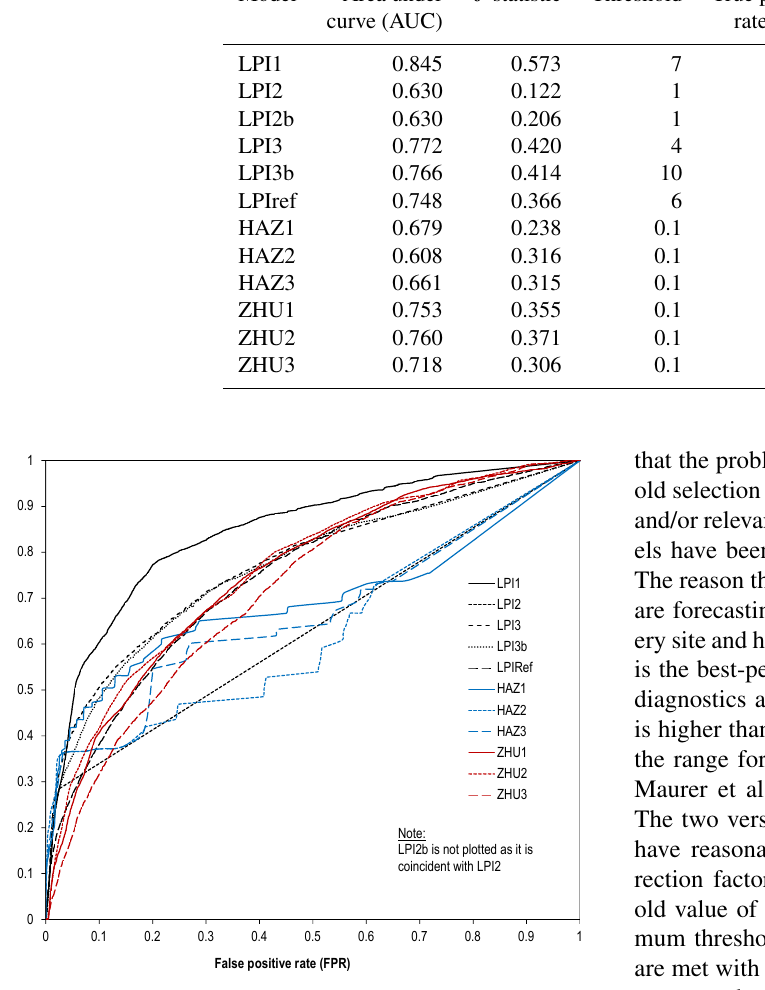
Figure 5. Receiver operating characteristic (ROC) curves for fore- casting models. Refer to Table 4 for descriptions corresponding to model